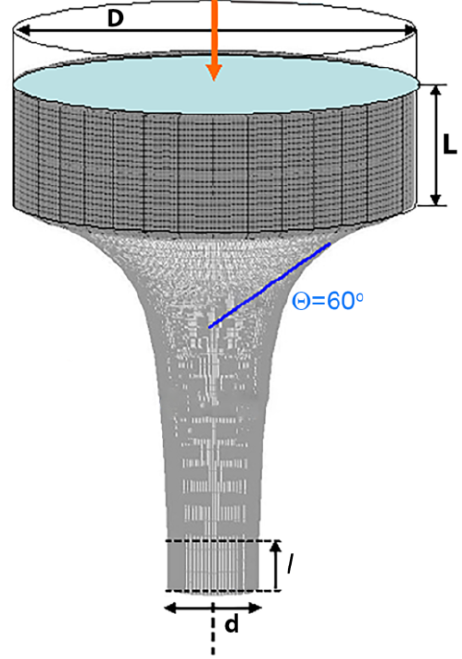
Figure 1. The scheme of hot extrusion process.